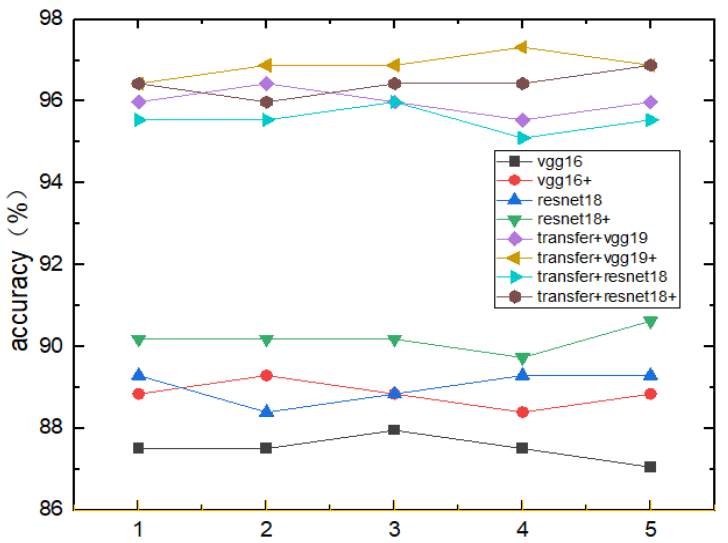
Figure 8. Plots of the five classification results. Transfer + denotes transfer learning, and + denotes using “simulated side-scan sonar images” in the training set.